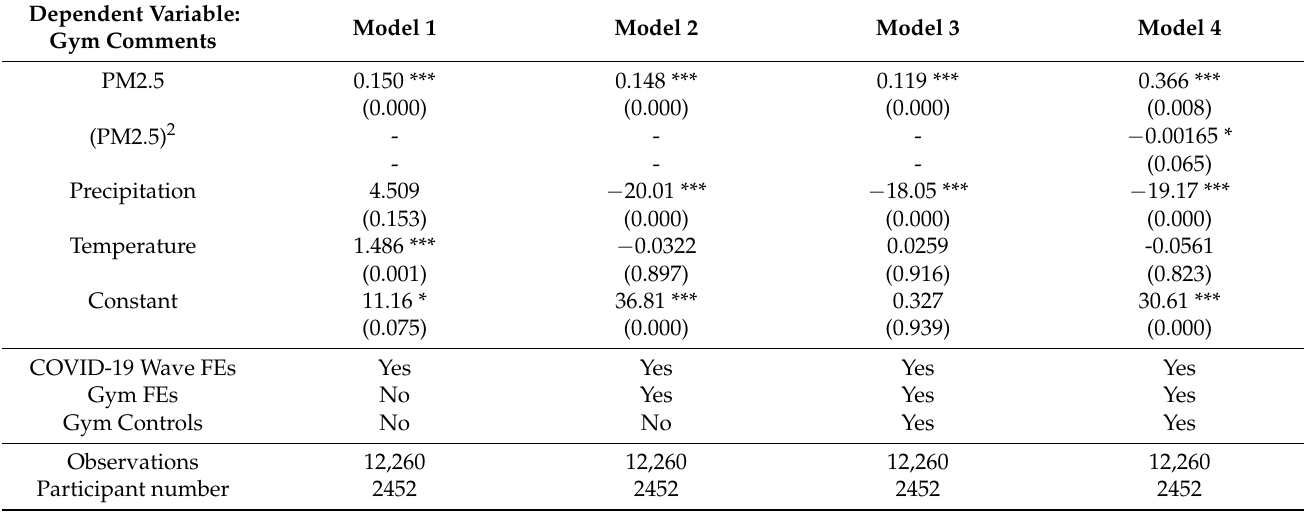
Table 4. Estimated associations between PM2.5 and gym visits from the OLS